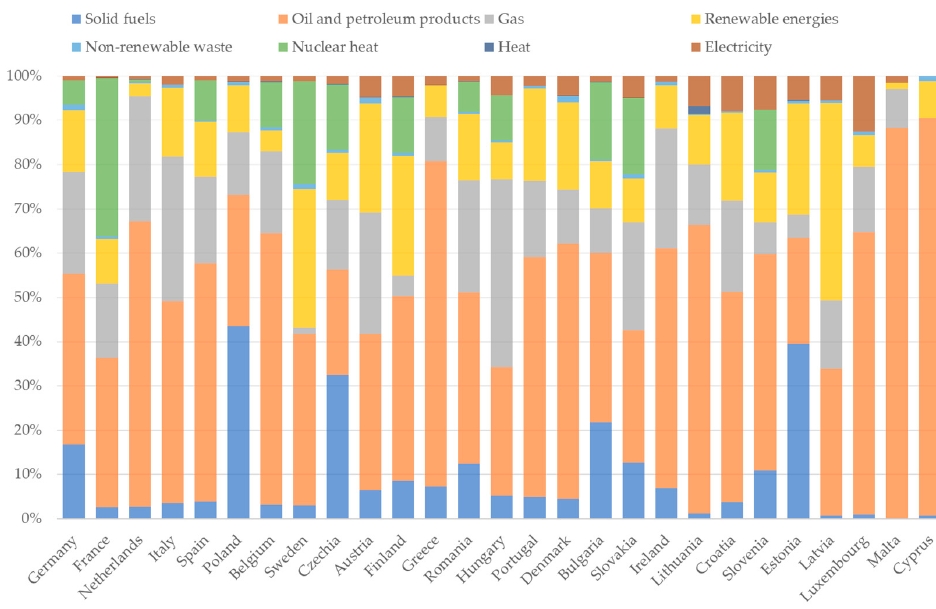
Figure 25. Fuels available from all sources in the EU-27 in 2019 (adopted from Eurostat data).